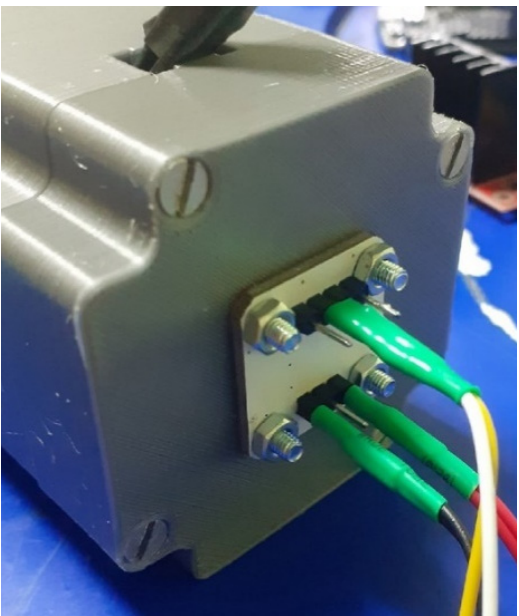
Figure 13. Placing of the AS5600 magnetic encoder. The prototype is fully assembled and functional (Figure 14).